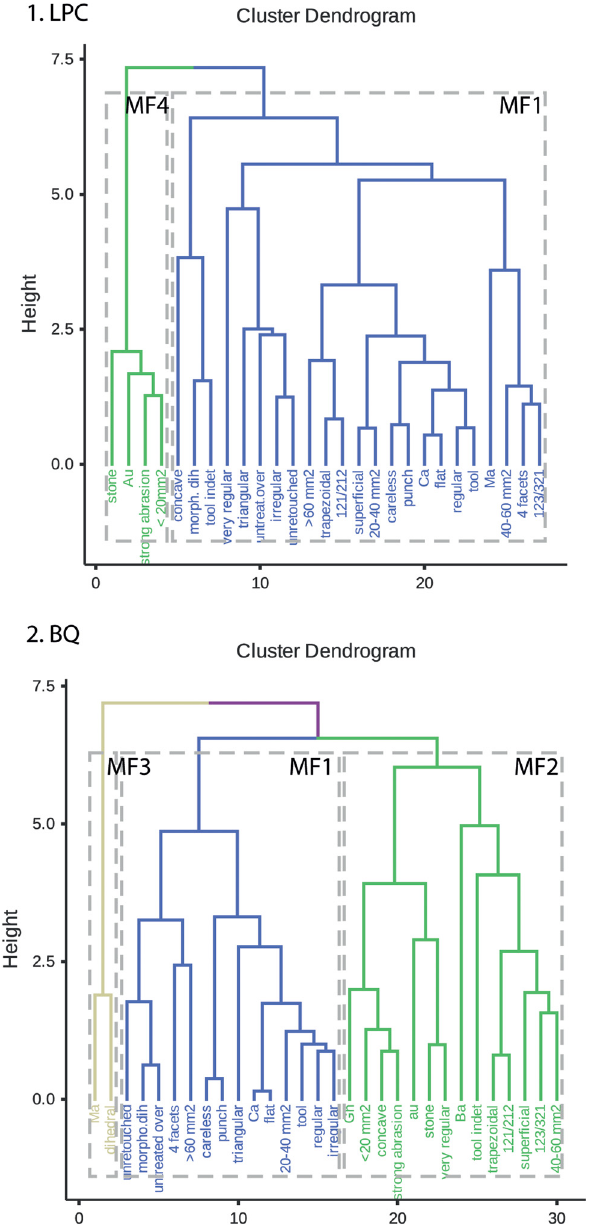
Figure 4: Cluster analysis made on the values of cumulative percentages explaining the position of individual variables on the fi ve axes of the correspondence analysis to understand the relationship of variables within the LPC dataset ( no. 1 ) and the Blicquy dataset ( no. 2 ) . The main technical groups are well identi fi ed within the structures. See descriptive variables in the caption of Figure